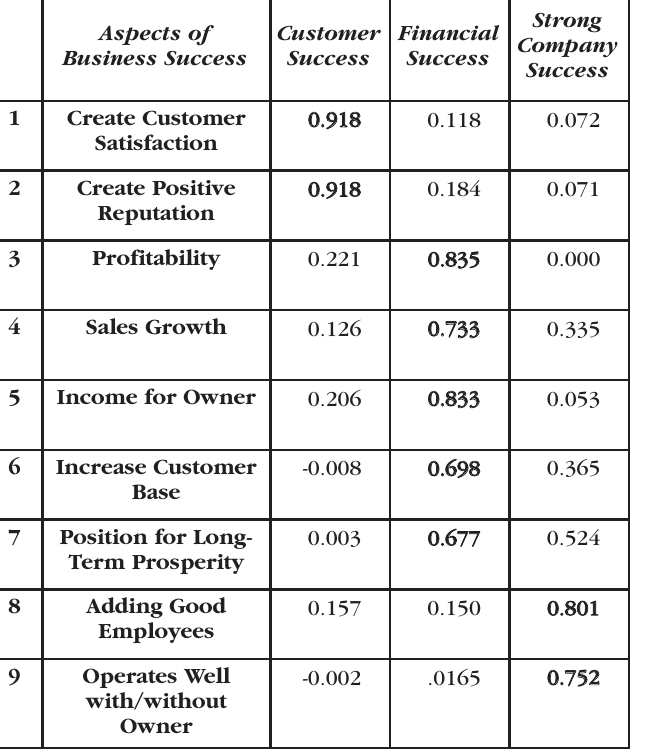
Table 2. Factor Analysis of Success Outcomes Aspects of Business Success